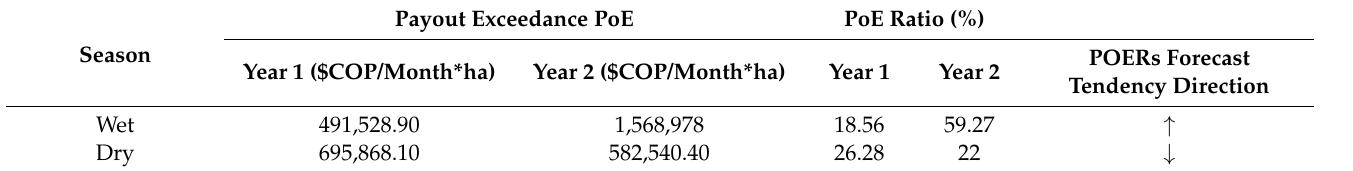
Table 7. Future payouts in exceedance (PoEs) and ratios (POERs) for 2 years ahead. Note: arrows reflect the direction of the tendency. Source: author’s processing.